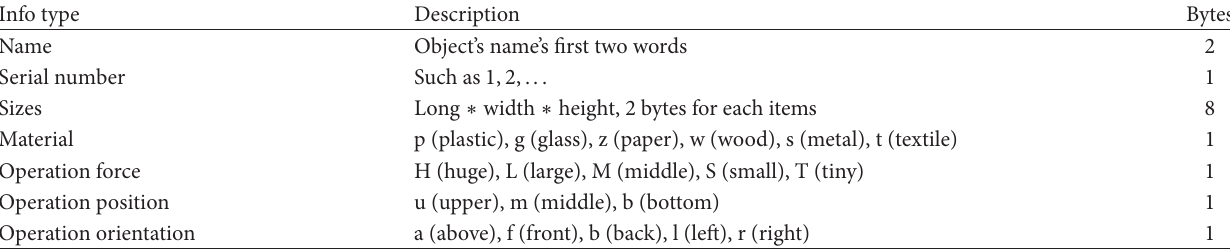
Table 1: Coding of information stored in QR Code-based artificial object mark.